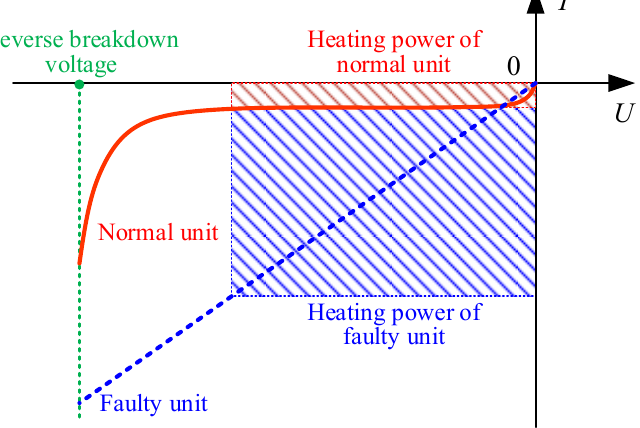
Figure 3. Output I-U characteristic of battery unit in reverse bias state.